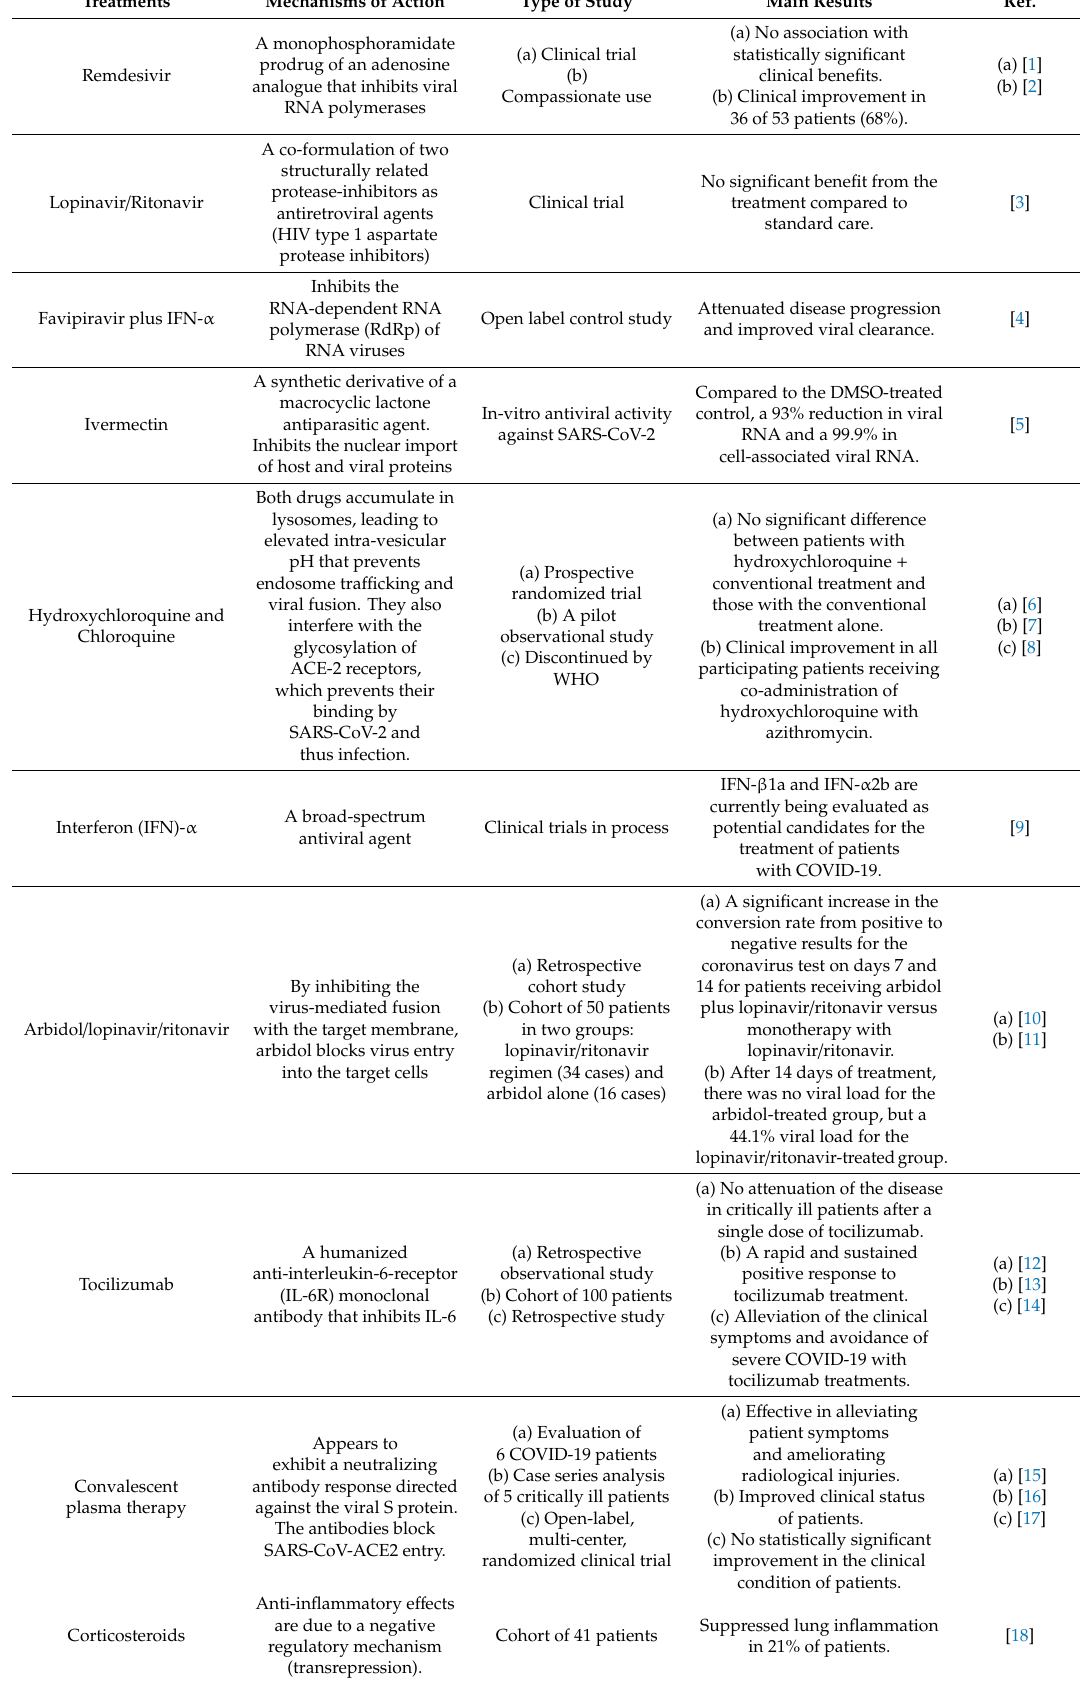
Table 1. The main treatments that have been administered to COVID-19